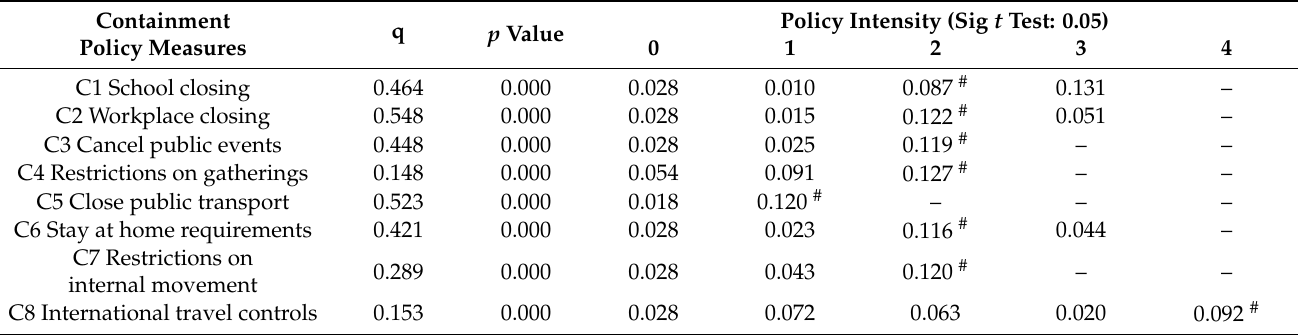
Table 2. q-statistics of different policy